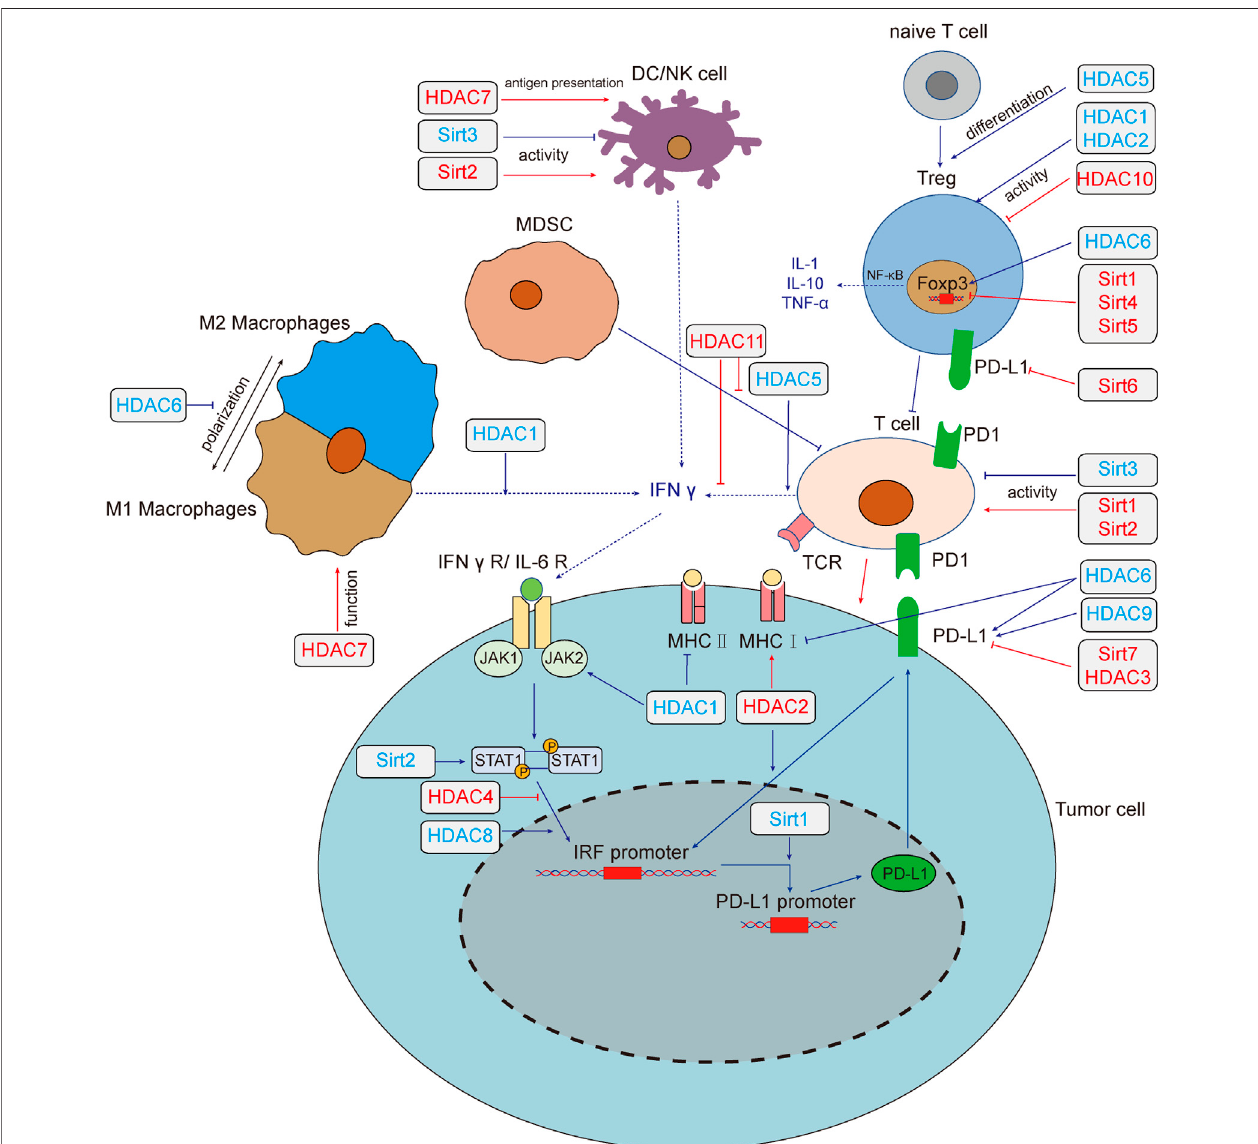
FIGURE 1 | HADCs regulate tumor immunity and tumor immune microenvironment. Deacetylase regulates tumor immune response through multiple pathways. HDAC1,3,4,6,8,9 and Sirt1,2,6,7 regulate the expression of PD-L1 by regulating the IFN signaling pathway. HDAC1,2,6 regulates the expression of MHC, which affect the recognition of tumor cells by T cells. Sirt1, 2, 3 affect tumor immunity by changing the activity of T cells, HDAC1, 2, 10 could affect the function of Treg cells, and HDAC5 promotes the differentiation of naive T cells into Treg cells. Sirt2,3 could affect the activity of NK cells. HDAC7 both enhances the anti-tumor function of macrophages and the antigen presentation function of DC cells. HDAC1, 5, 6, 11 and Sirt1, 4, 5 modulate the tumor microenvironment by affecting the secretion of cytokines.Redlinesandtextcolorsrepresentthepromotingeffectsoftumorimmunity,whilebluerepresentsthetumorimmunosuppressioneffects.Dottedlinesindicate the regulation and function of cytokines. Abbreviations: T cell, T lymphocyte; NK, natural killer cell; DC, dendritic cells; MDSC, myeloid-derived suppressor cell; IFN- γ , interferon- γ ;IFN γ R,interferon- γ receptor;IL,interleukin;JAK,Januskinase;STAT,signaltransducerandactivatoroftranscription;TNF- α ,tumornecrosisfactor- α ;Treg, regulatory T cell; IRF, interferon regulatory factor; PD-L1, programmed death-ligand 1; MHC, major histocompatibility complex; Sirt, sirtuins; HDAC, histone deacetylases.